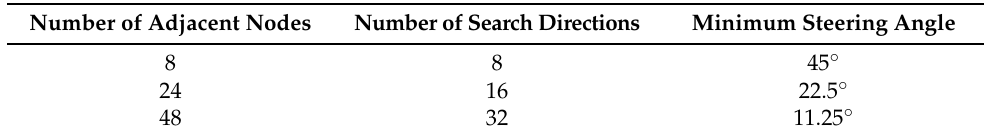
Table 1. Relationship between number of adjacent nodes, number of search directions and minimum steering angle.